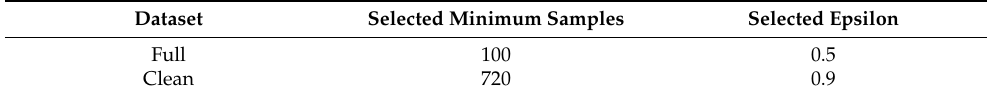
Table A3. Parameters used for DBSCAN.